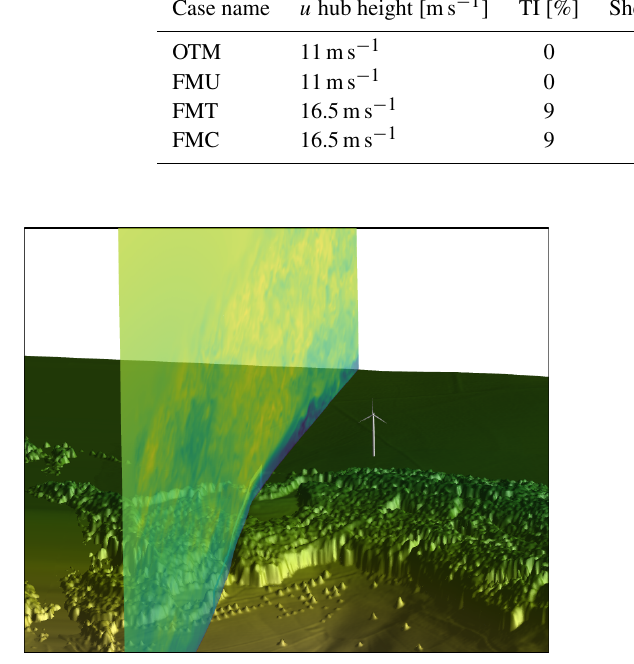
Figure 3. CFD model of the complex terrain considering the forest with a slice of the velocity field 2.5D from the turbine on its right- hand side. Table 4. Number of nodes/elements for each structure in both beam and shell models.